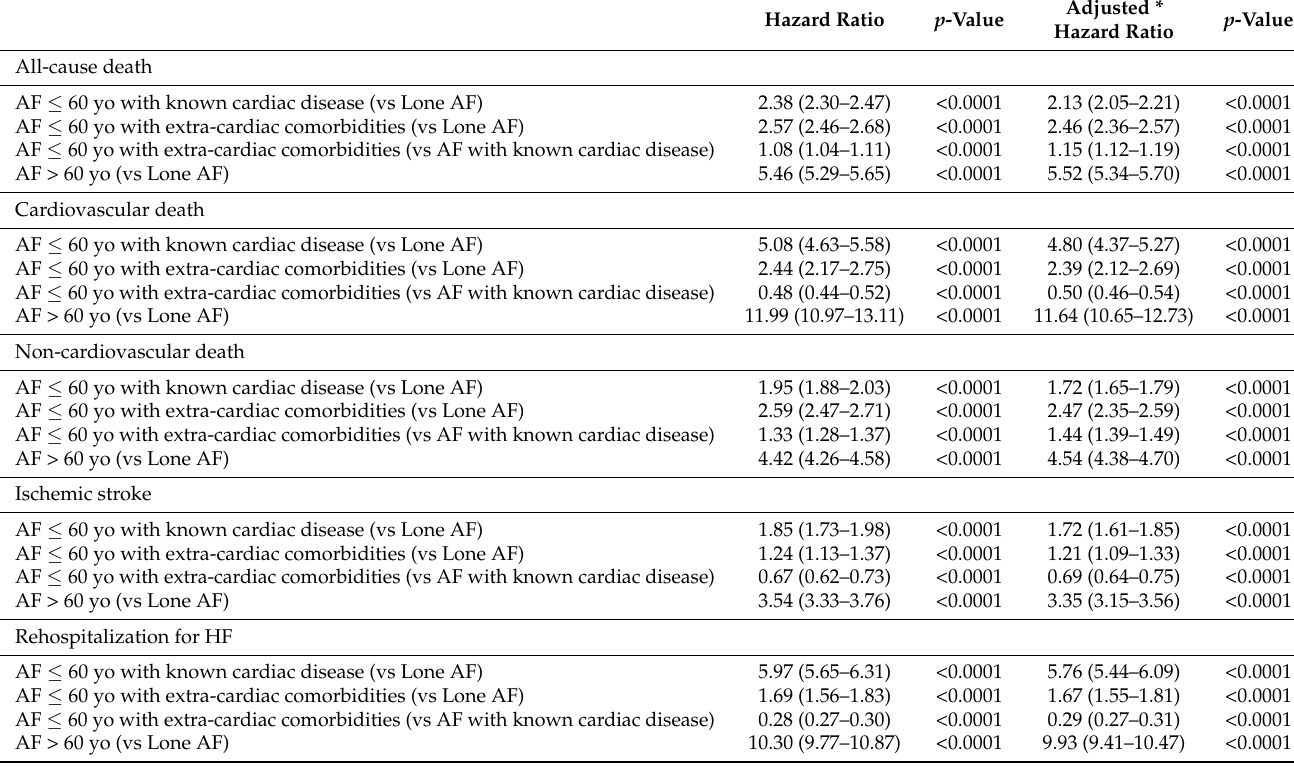
Table 3. Hazard ratios (95% CI) associated with type of AF for the incident outcome of